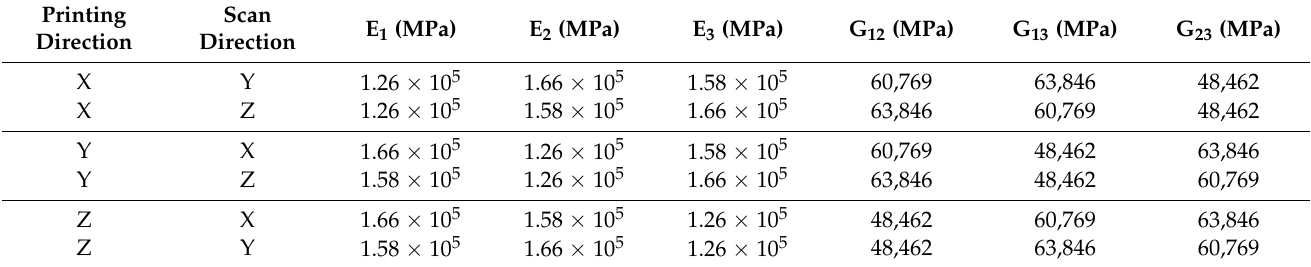
Table 4. Elastic constant.